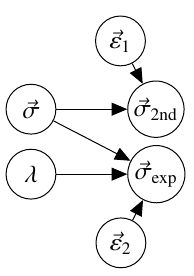
Figure 2. Bayesian network for the evaluation example. See the text for a description of the nodes and